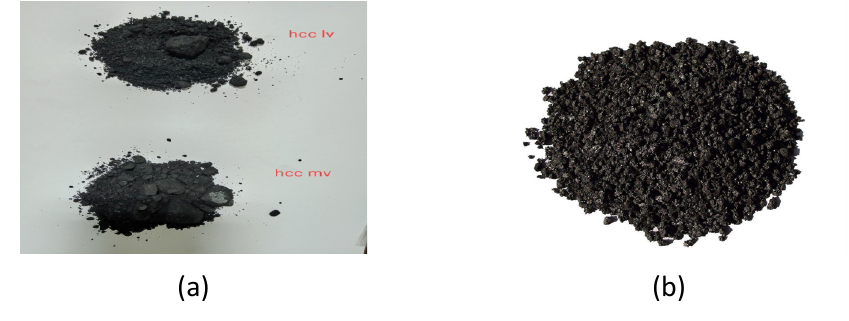
Figure 1: Comparison of GPC with coal (a) GPC and (b) HCC coal.